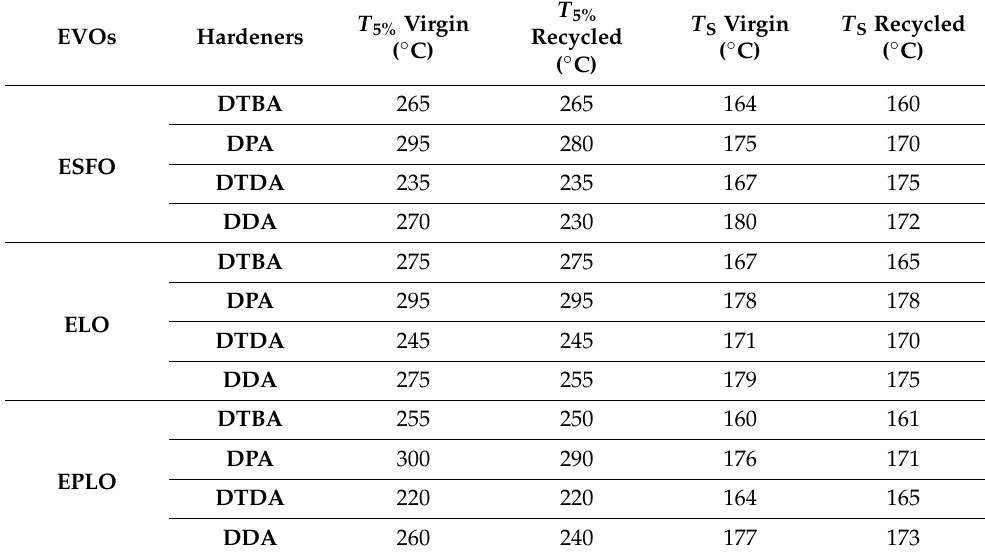
Figure 7. TGA analyses and comparison between the virgin and recycled resins, aromatic ( A – C ) or aliphatic ( D – F ) crosslinkers. Heating at 10 ◦ C/min, under air. Table 4. Thermal stability data, T 5% and statistic heat-resistant index temperature ( T S ) of virgin and recycled thermosets.